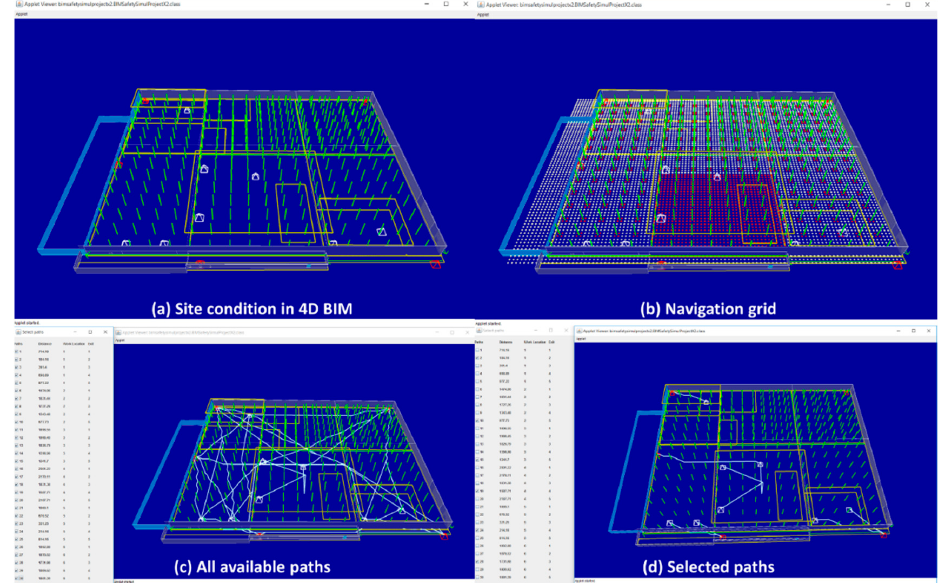
Figure 16. Evaluation paths from roofing work locations in scenario 2. Figure 17. Scenario 3 ( a ) site condition, ( b ) navigation grid, ( c ) all available paths, and ( d ) selected paths.